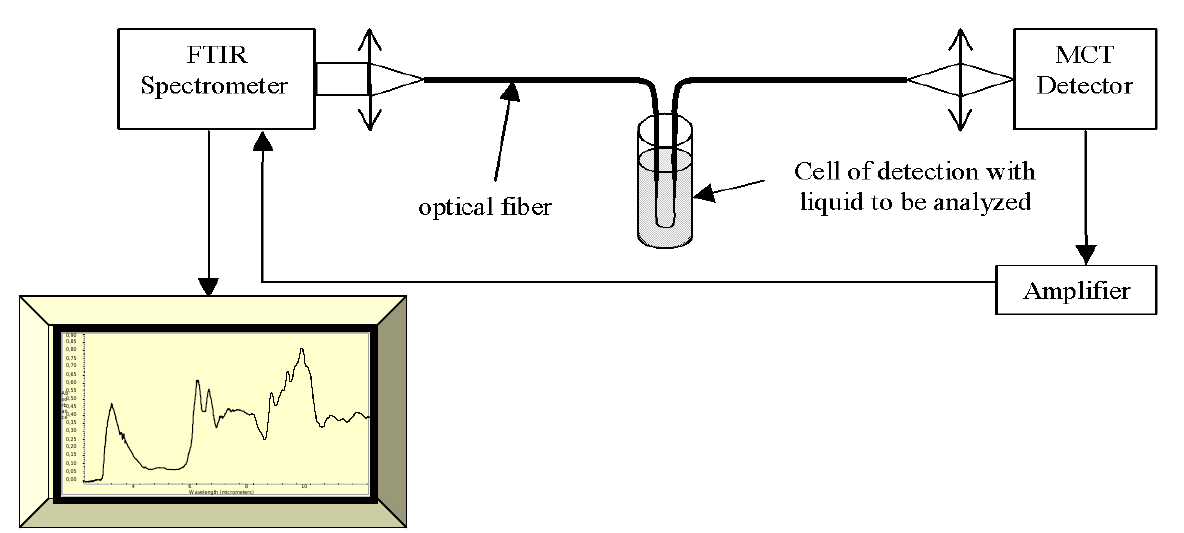
Figure 1. Schematic representation of the experimental set up used for FEWS experiments. It is composed of an IR source, a chalcogenide